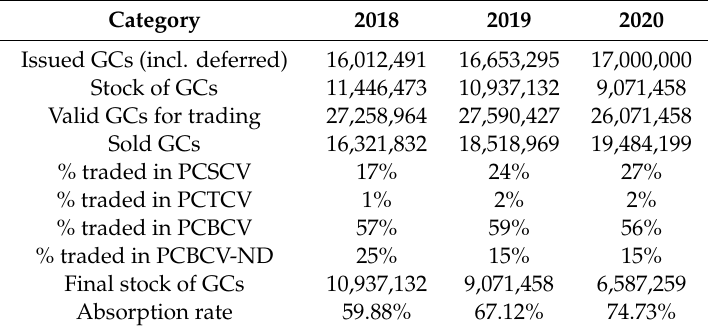
Table 3. The situation of green certificates (GCs) and the share of deals in the GC